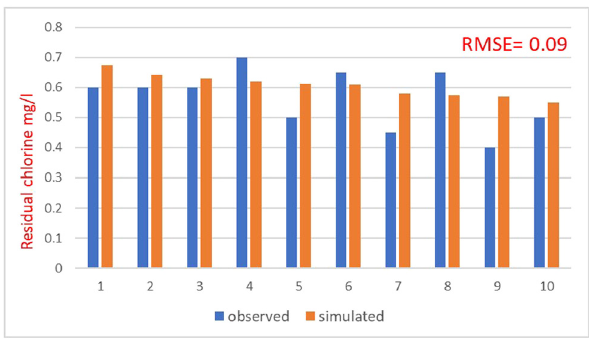
Figure 7: Comparison between simulated and fi eld - measured of the residual chlorine concentrations at di ff erent junctions.